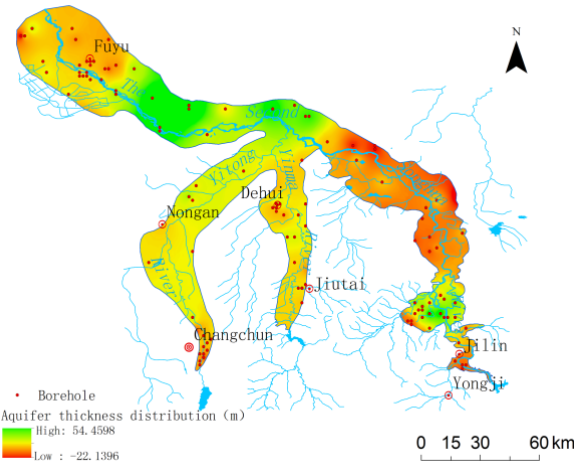
Figure 7. Distribution of aquifer thickness.